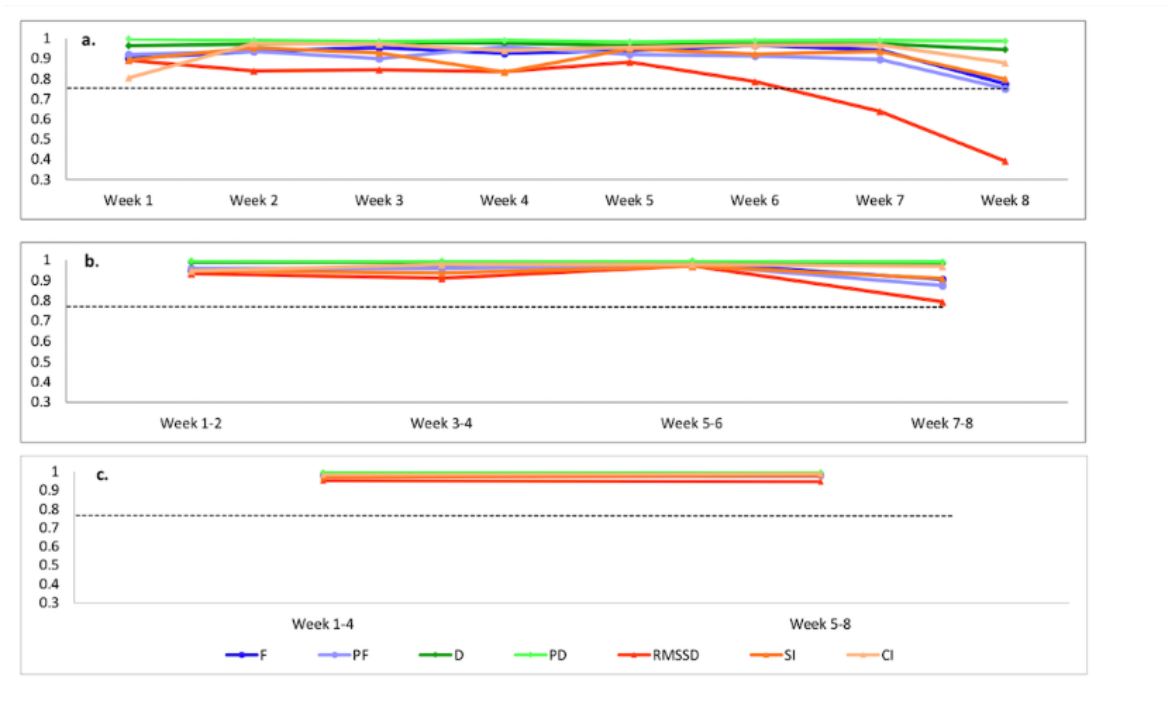
Figure 3. The temporal stability of app-generated parameters: Fundamental time unit. (a) The correlation coefficients between 1-week use and 2-month use for app-generated parameters. (b) The correlation coefficients between 2-week use and 2-month use for app-generated parameters. (c) The correlation coefficients between 4-week use and 2-month use for app-generated parameters. CI: Control Index; F: Total use frequency; D: Total use duration; PD: Proactive use duration; PF: Proactive use frequency; RMSSD: root mean square of the successive differences (between the adjacent duration of use and nonuse episodes); SI: Similarity